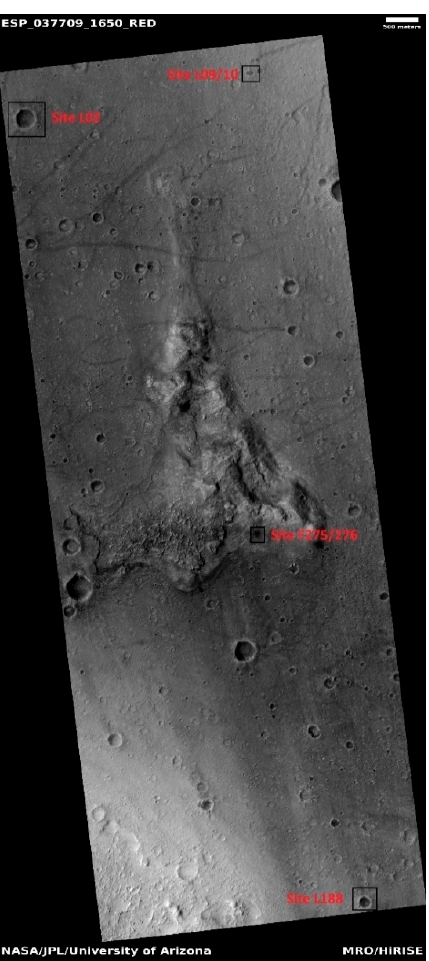
Figure 11. Meridini Plain MER Spirit landing and exploration site. Four TAR test sites indicated.